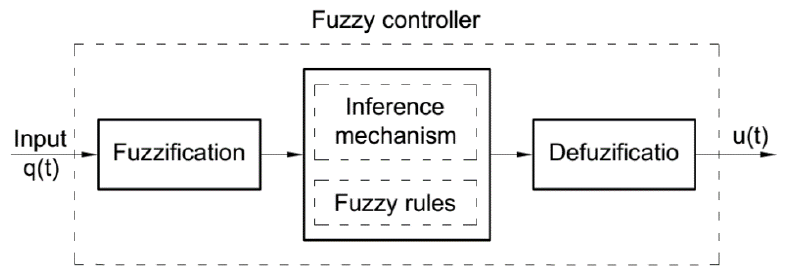
Figure B1. A general fuzzy controller. Figure A1. A general fuzzy